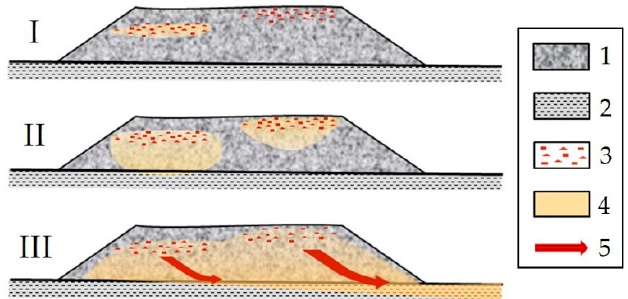
Figure 2. The accumulation process of the reserves at an MMPW site. ( I )—disposal in the initial stage; ( II )—disposal in the early storage stage; ( III )—disposal after a long-term storage period. 1—dump